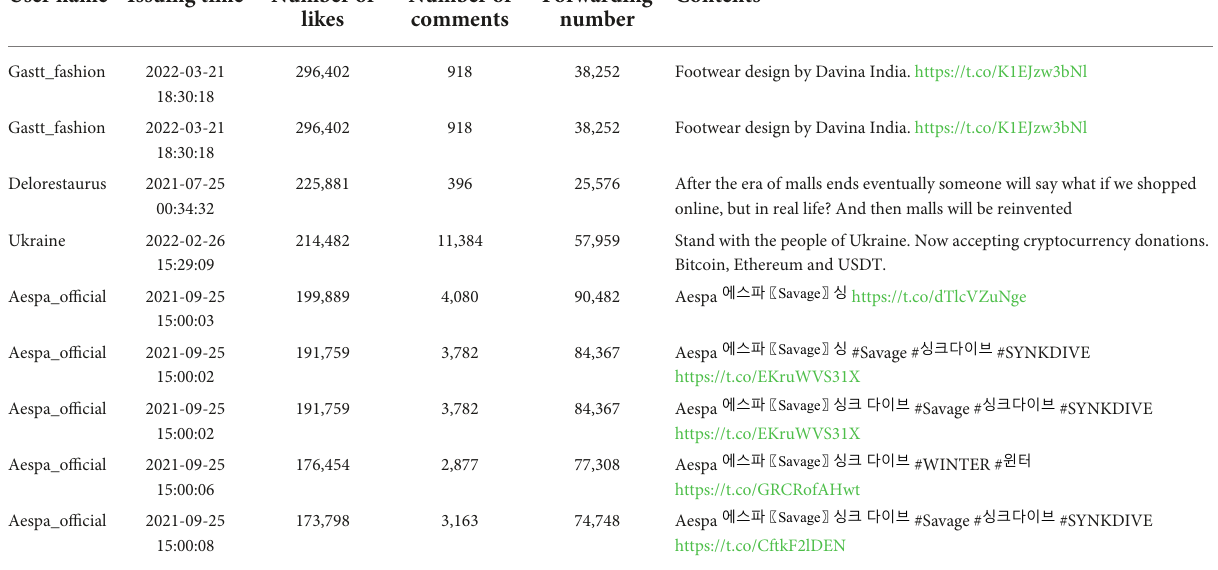
TABLE 2a Original posts collected by keyword “digital fashion” on Twitter.